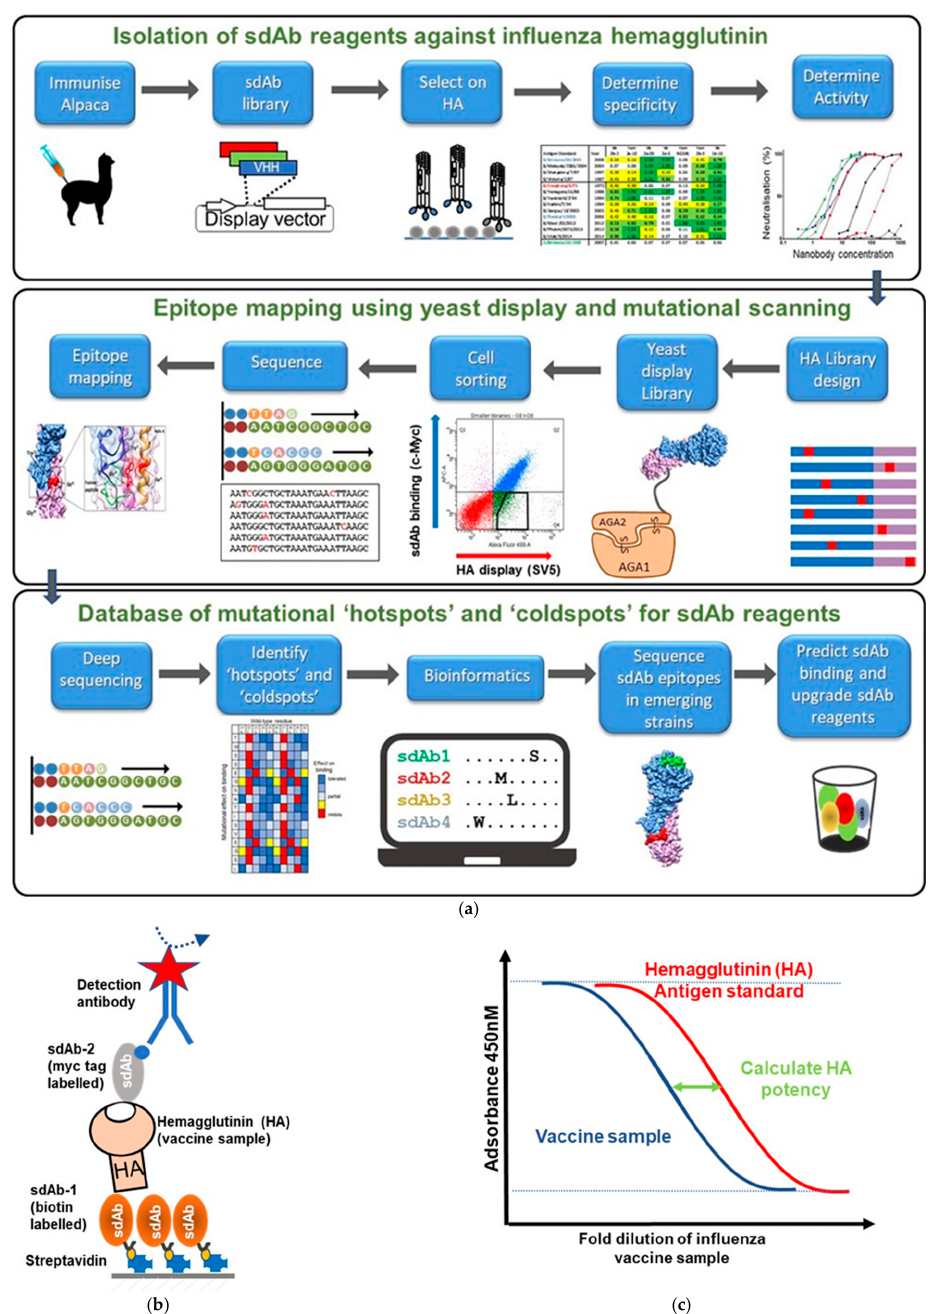
Figure 4. Isolation and epitope mapping of single domain antibodies against influenza hemagglutinin (HA) and applications in vaccine potency testing. ( a ) Adapted from [73]. Generation of panels of high affinity sdAbs against influenza HA using immunisation of alpacas with HA from key group 1, group 2 IAV and IBV strains. Construction of a sdAb (nanobody) display library and selection for antigen specific sdAbs with both broad reactivity and lineage specific binding for use